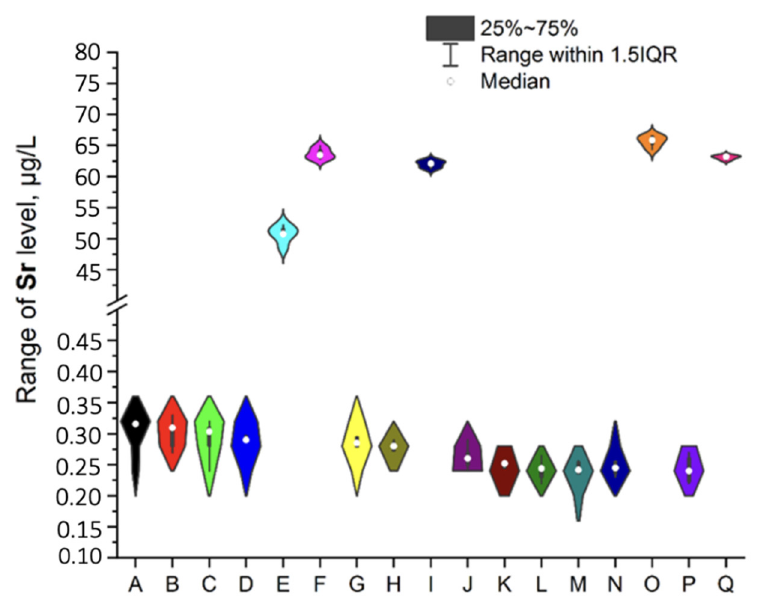
Figure 6. The plot as a violin with the box for the Se level (µg/L) in the examined products (A–Q).